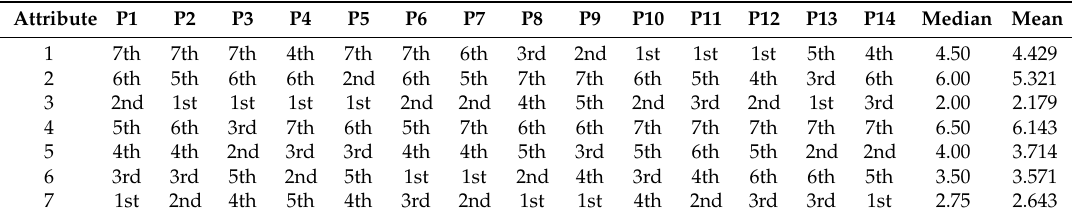
Table 3. Ranking of importance of the seven attributes subjected to conjoint analysis involving 14 participating practitioners.